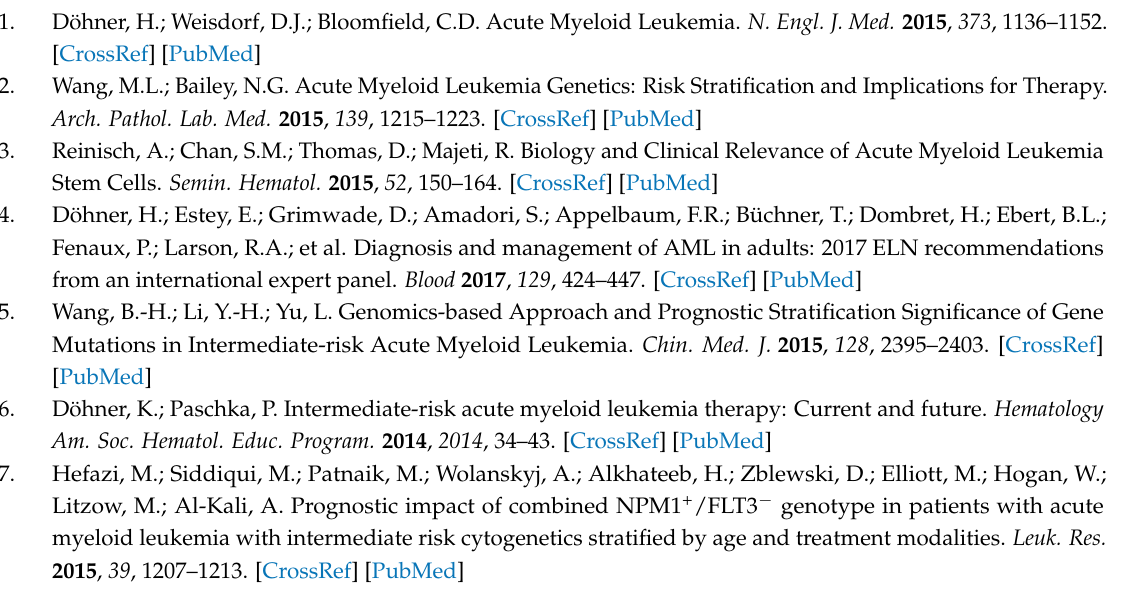
Table S3: Time-dependent endpoints analyses regarding clinical characteristics of the cytogenetic IR-AML with non-favorable FLT3/NPM combination included in our patient cohort. Description: The results for the median of follow up are presented as the number of patients (range) for each condition; for the patient status as the number of patients (%); and for all the others as the estimates in percentage ± the standard error. Log-rank test was used to analyze the statistical significance for each variable. p < 0.05 was considered statistically significant (bold values). NS represents not significant differences, and the estimates were not included in the table. CR; Complete remission. OS; Overall survival. DFS; Disease-free survival. CIR; Cumulative incidence of